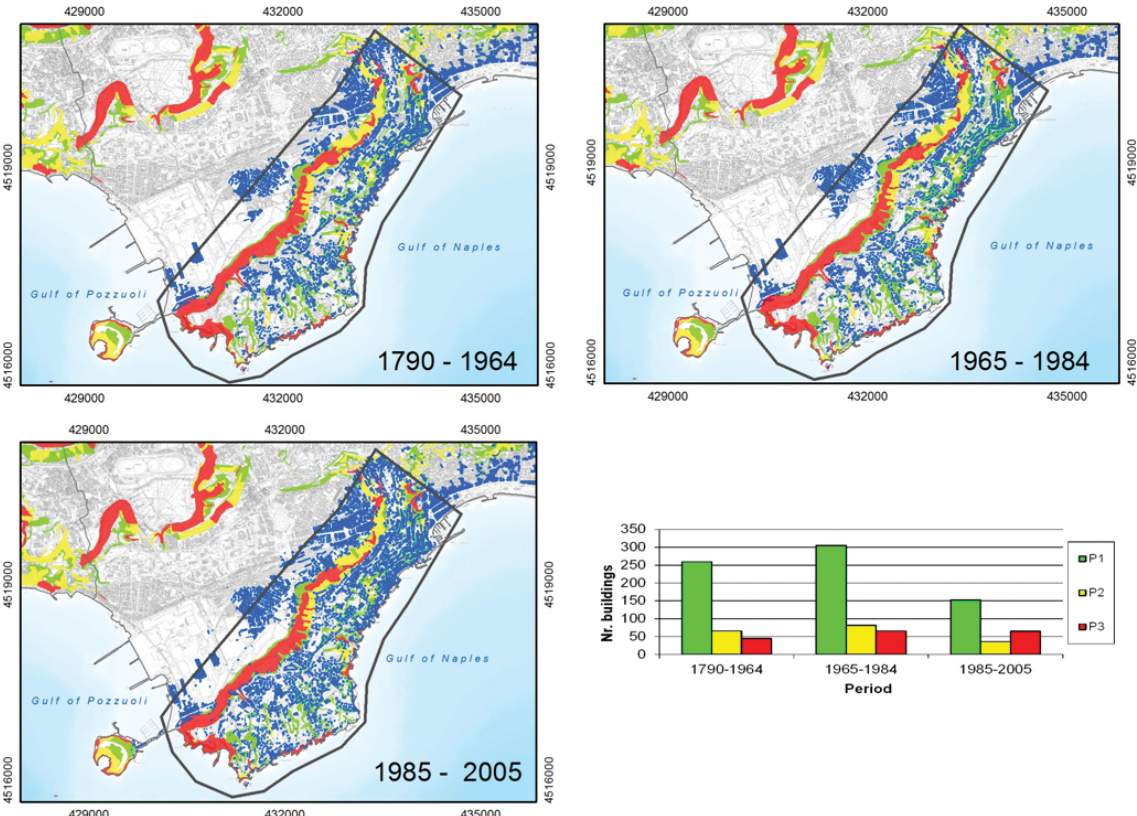
Fig. 18. 1790–2005 temporal distribution of the dwellings built at Posillipo, Naples. Key to symbols: P1 = low relative hazard; P2 = medium relative hazard; P3 = high relative